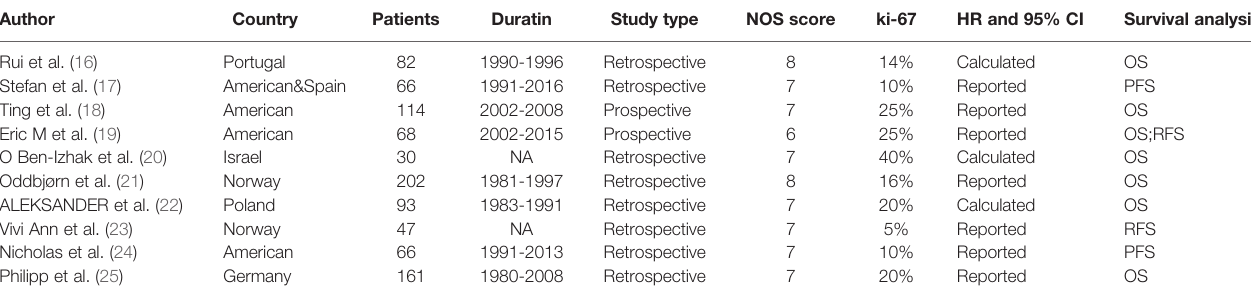
TABLE 1 | Characteristics of the included